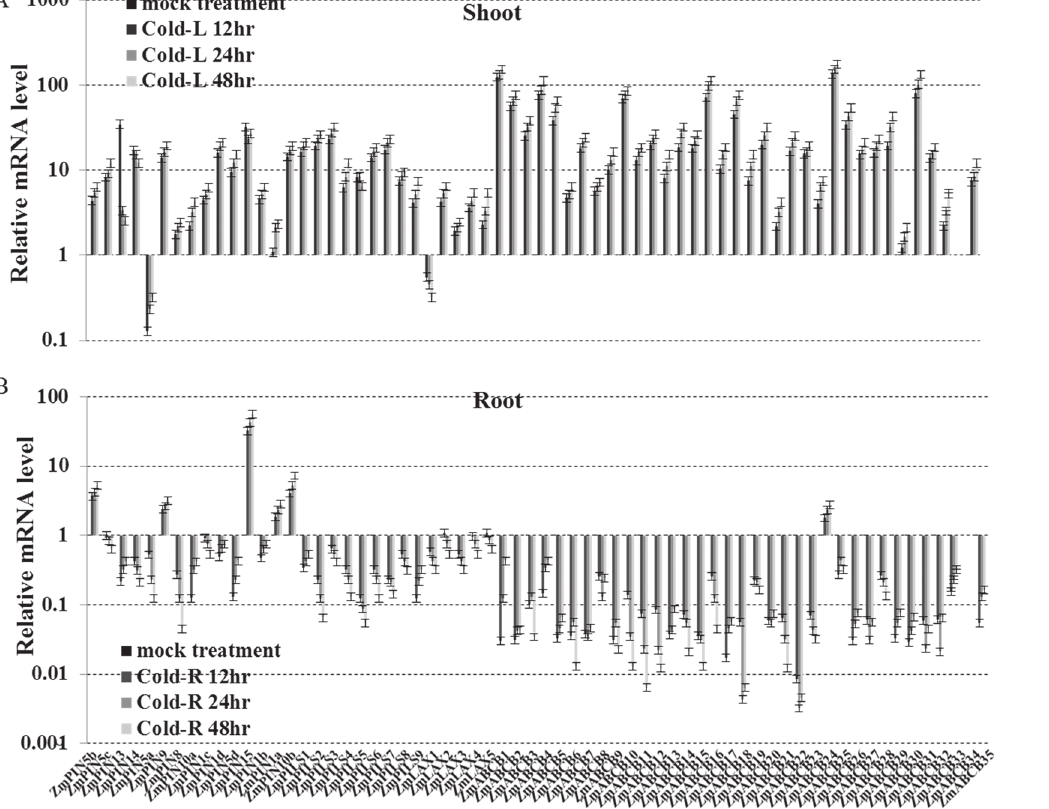
Fig 7. Expression levels of ZmPIN , ZmPILS , ZmLAX and ZmABCB gene families in response to cold. Expression levels of ZmPIN , ZmPILS , ZmLAX and ZmABCB genes were analyzed by qRT-PCR in both shoot (A) and roots (B) of 14-day-old seedlings, which were treated with cold (4°C) for 48 hours. The relative expression levels were normalized to a value of 1 in mock seedlings. Error bars represent SD from five biological replicates.